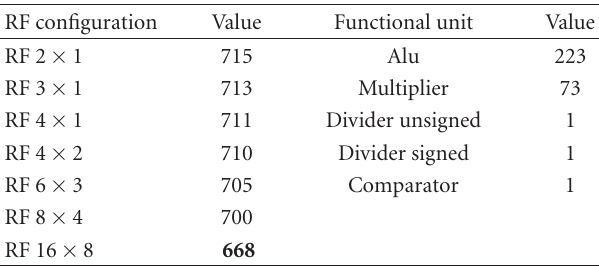
Table 3: Register file (RF) mapping function values and functional unit mapping.